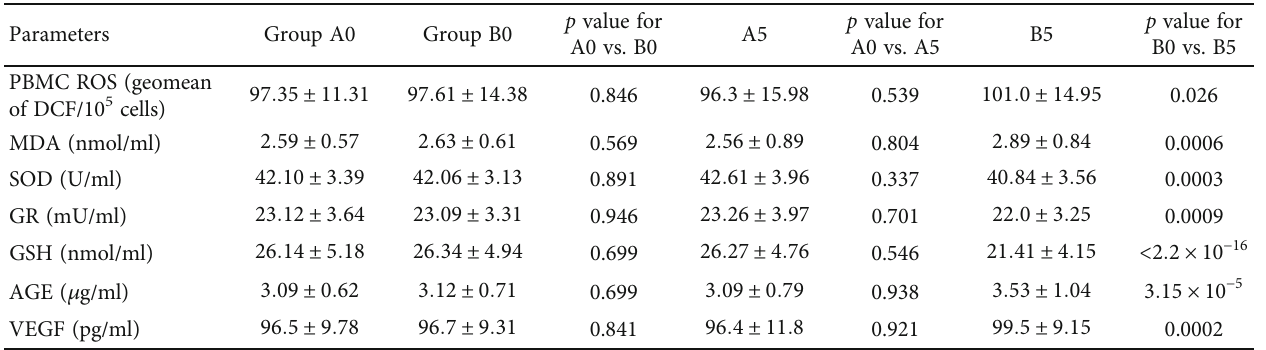
Table 2: Comparison of di ff erent biochemical parameters between the groups at baseline and within the groups after 5 years. Parameters